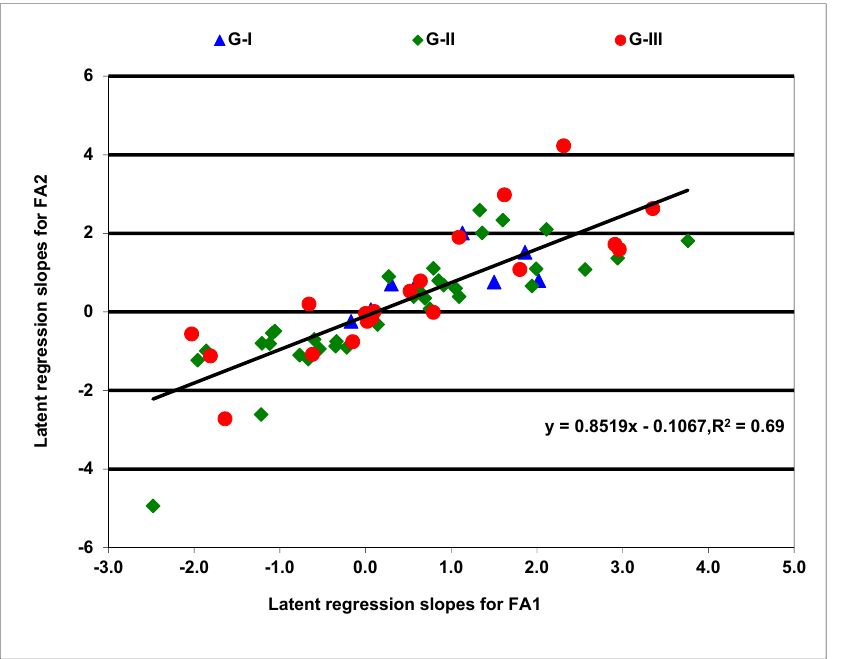
Figure 3. Latent regression line slopes of the first two factors for grain yield of maize hybrids were obtained from a factor analytic model. Hybrids marked blue belong to the first group (G-I), those marked green represent the second group (G-II), and those marked red were included in the third group (G-III).